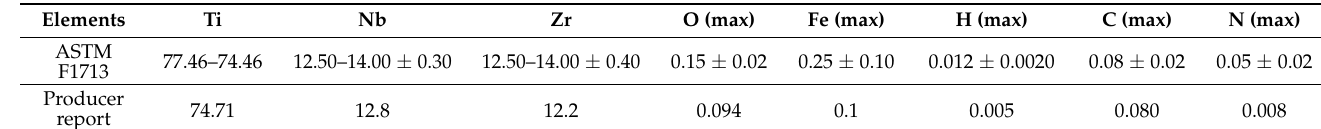
Table 2. Chemical composition of Ti-13Nb-13Zr alloy in (wt%).